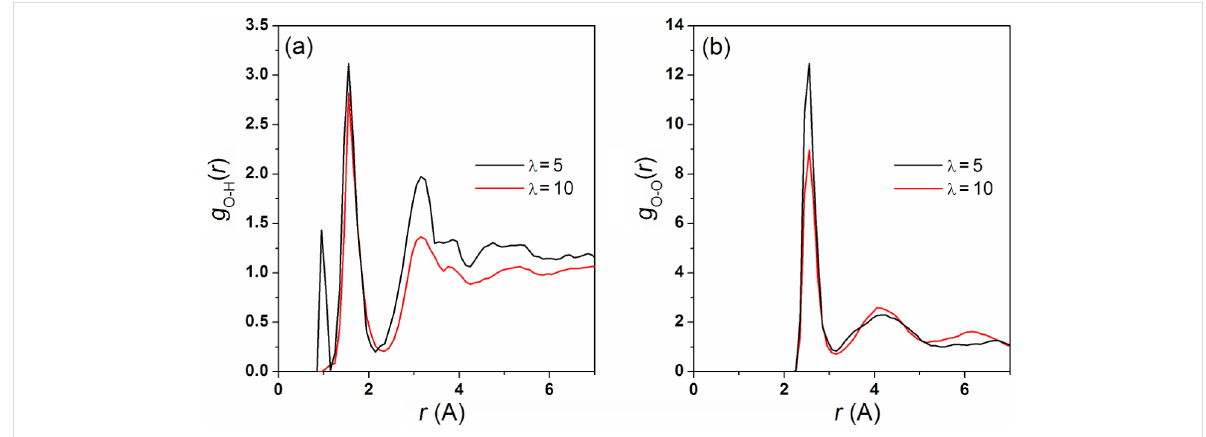
Figure 12: (a) Pair correlation functions, g OH ( r ), for the oxygen atoms of the SO 3 groups and any proton, at λ = 5 and 10. (b) Pair correlation func- tions, g OO ( r ), for the oxygen atoms of H 2 O and proton–water complexes, at λ = 5 and